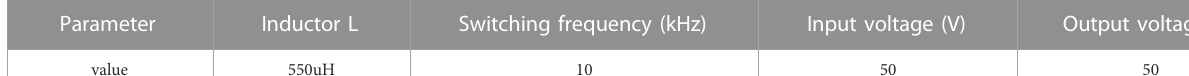
TABLE 1 Parameters of the DAB-based